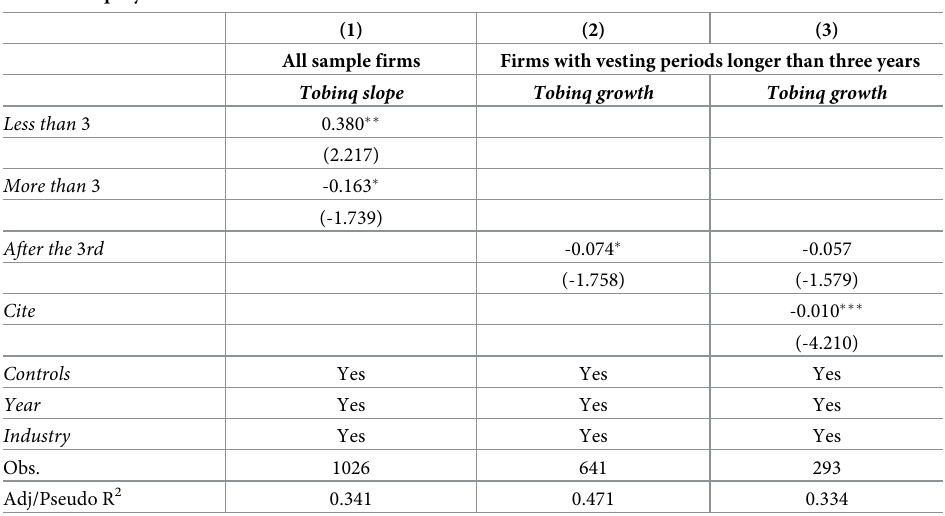
Table 11. Equity incentive and firm